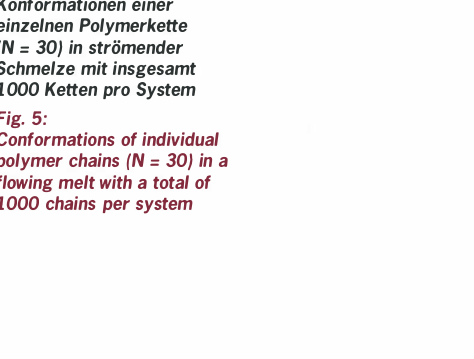
lengths. The shear thinning behavior at high shear rates obeys a power law equation. Extrapolated values of the viscosity at low shear rates are shown in Fig.